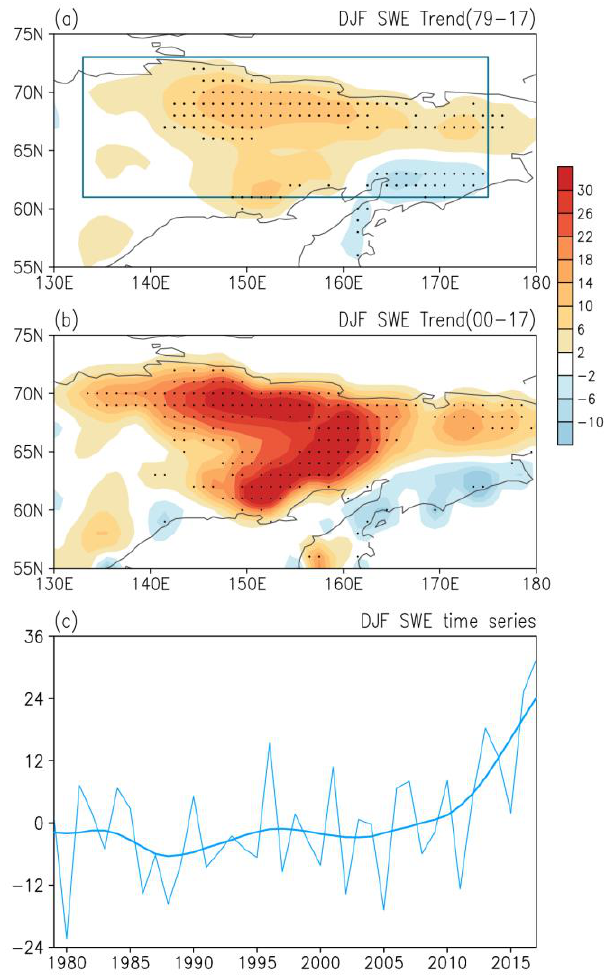
Figure 2. Linear trends of DJF SWE (mm month −1 10a −1 ) for the period ( a ) 1979 – 2017 and ( b ) 2000 – 2017 based on monthly data. ( c ) Time series of area-mean DJF SWE (mm month −1 ) anomalies for the period 1979 – 2017 in east Siberia (blue box covered area); thick line is obtained by an 11-year Gaussian filter. Dotted regions in ( a , b ) denote trends significant at the 95% confidence level. The large extent of snow in east Siberia is mainly due to snowfall accumulation from October and later months. To understand the sources of winter SWE increase in east Siberia, we analyzed the trend of SWE difference for each month from October to Febru- ary and calculated the area-mean SWE difference of each month during 1979–2017. In October, the trend of the SWE difference is sporadic and has no obvious spatial char- acteristics (figures not shown). The most significant increase in the SWE difference